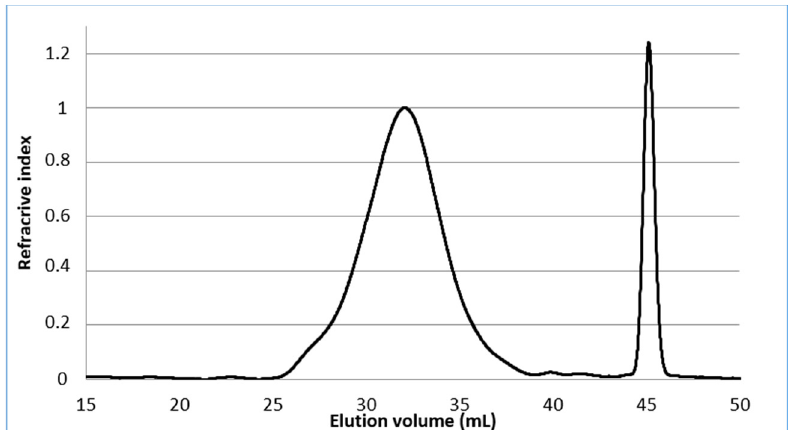
Figure 2. HPSEC analysis of pectin.